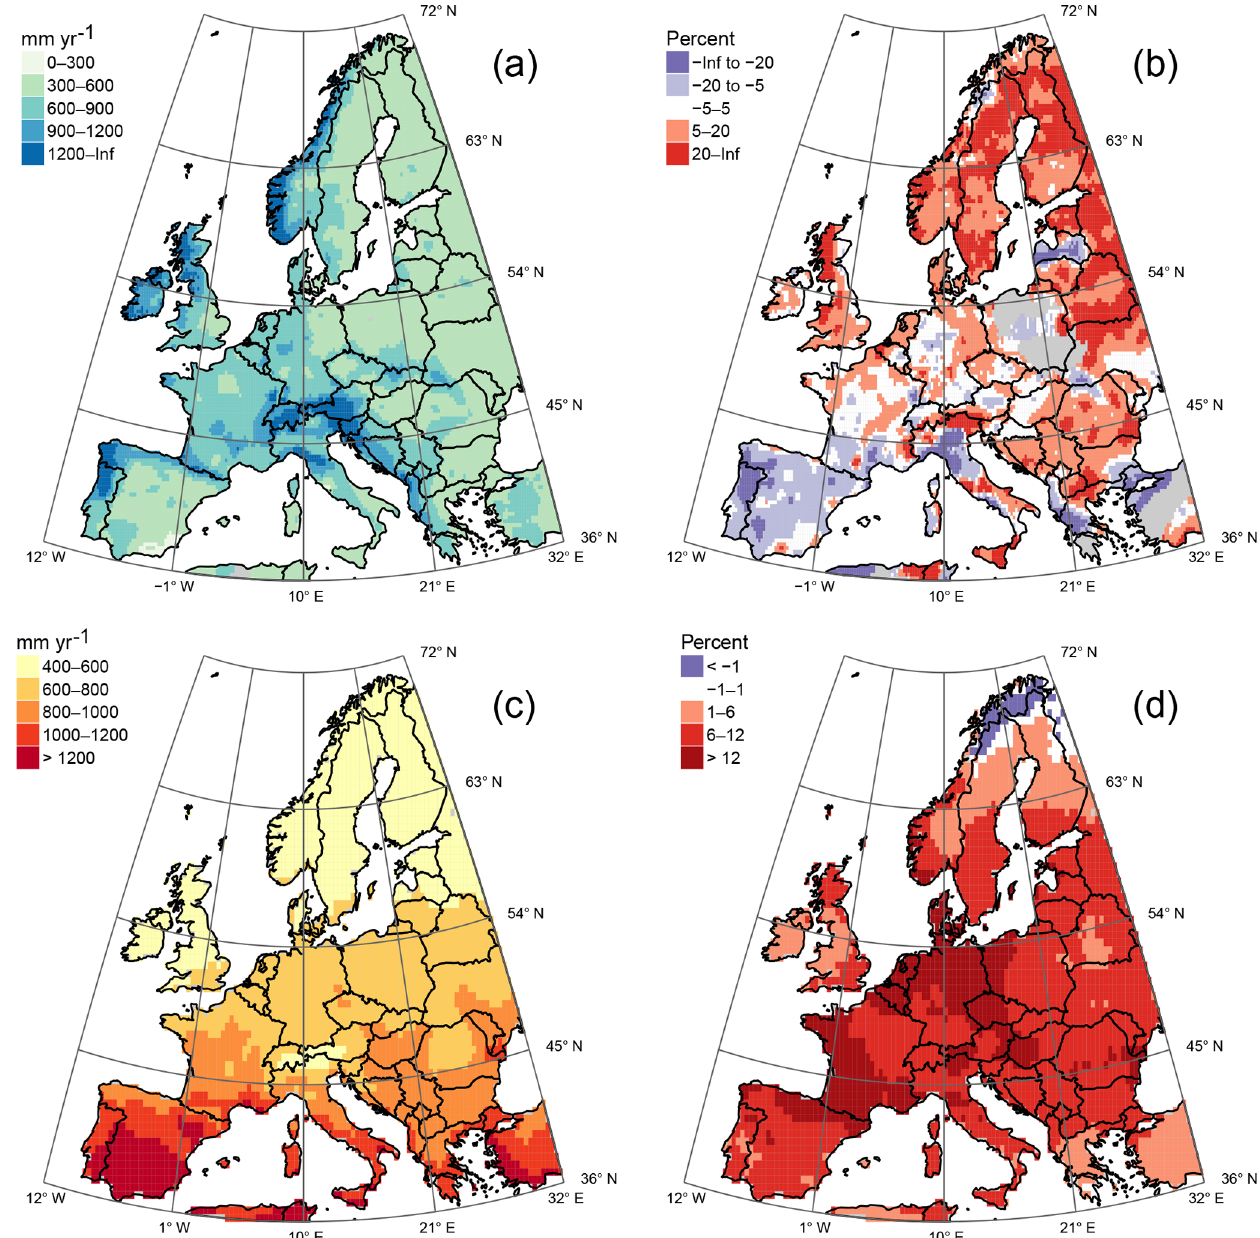
Figure 2. Climate characteristics over the period 1960–2010. Left panels show the mean precipitation and potential evapotranspiration ( a and c , respectively), while the right panels indicate the change over the period 1960–2010 for precipitation (b) and potential evapotranspira- tion (d)